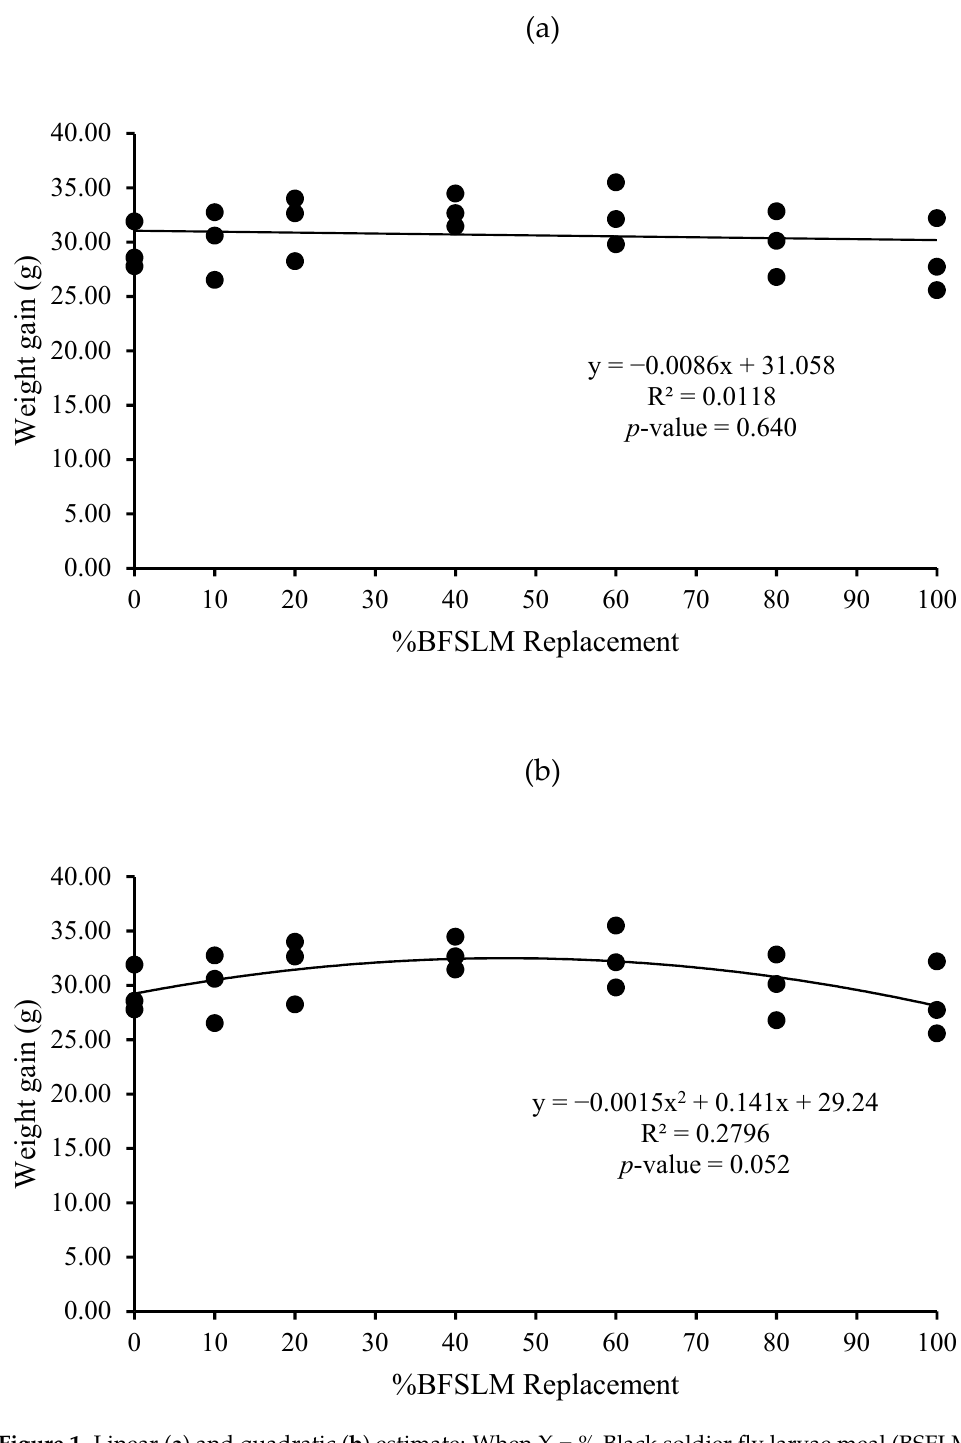
Figure 1. Linear ( a ) and quadratic ( b ) estimate: When X = % Black soldier fly larvae meal (BSFLM) replacement; Y = weight gained after 12 weeks of feeding with control (0% BSFLM and 100% fish meal (FM)), and FM replaced at 10%, 20%, 40%, 60%, 80%, and 100% of the BSFLM.